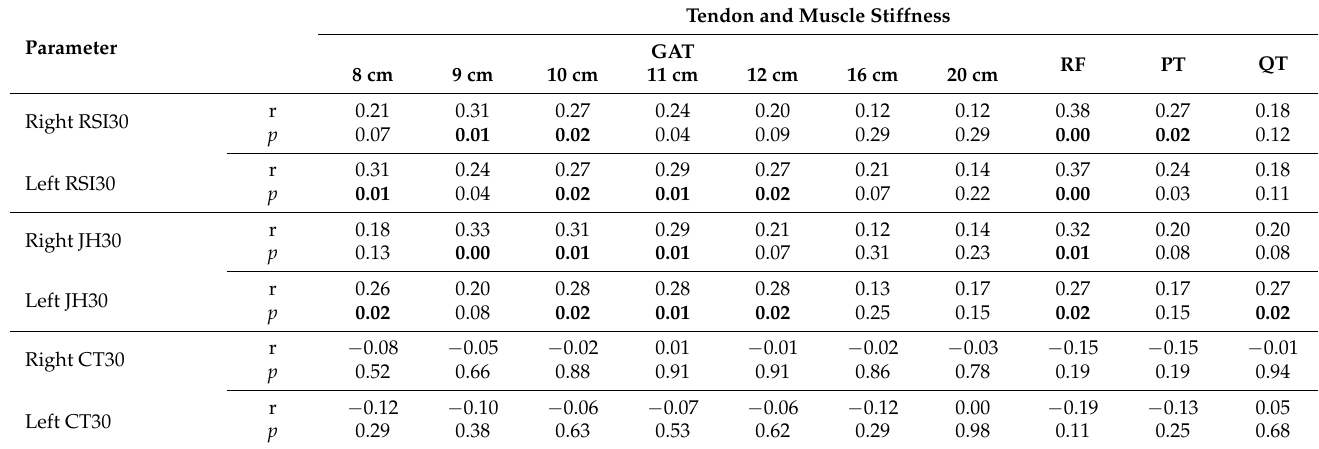
Table 3. Correlations between DJ30 performance parameters and stiffness.